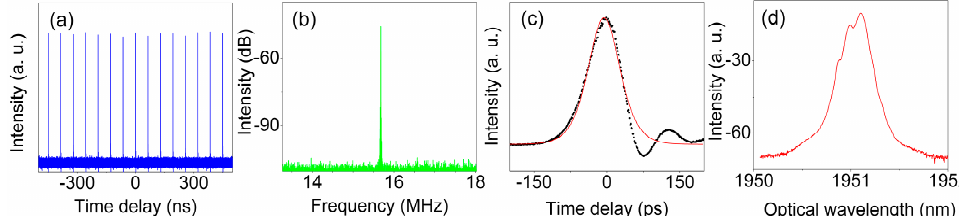
Figure 2. Laser with emission at 1.95 µ m. ( a ) Pulse train at the fundamental repetition rate. ( b ) RF spectrum showing the first harmonic. ( c ) Waveform of the single pulse in the time domain (solid black points) and its corresponding fitting by a square hyperbolic secant profile (solid red curve). ( d ) Measured spectrum of the output.